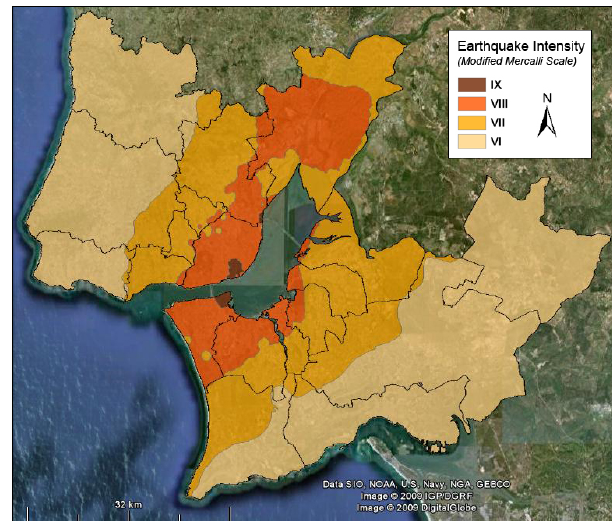
Fig. 2. Seismic Intensity map for the study area (background from Google